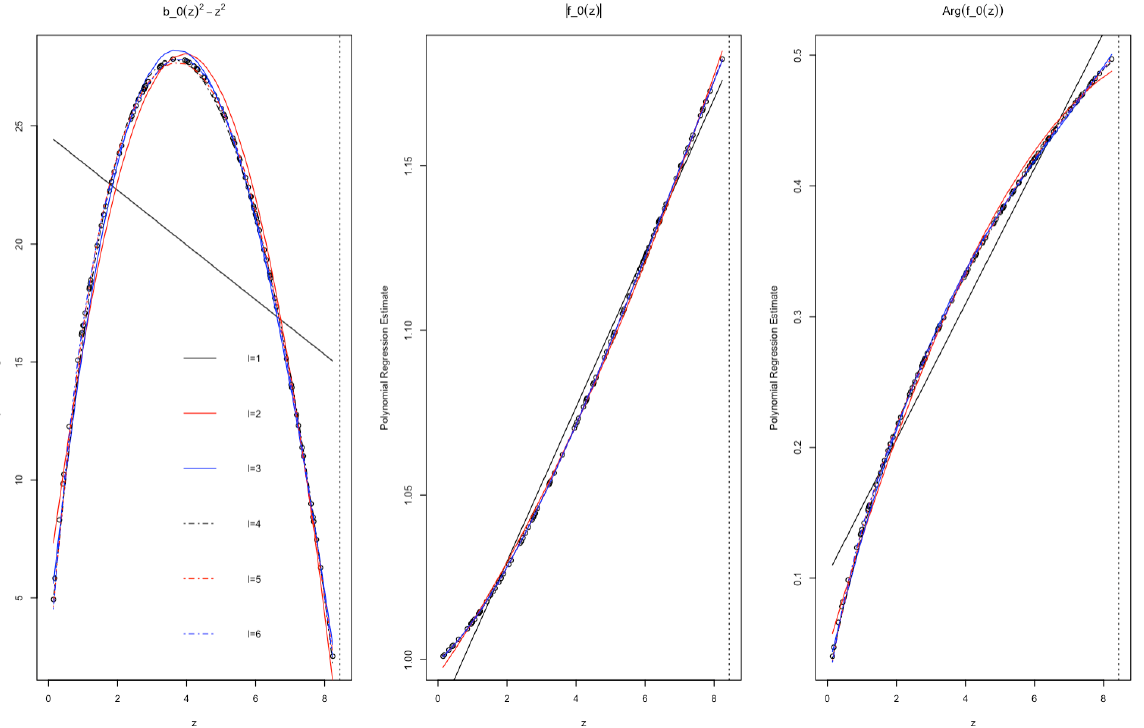
Figure 10. The estimates of critical collapse functions corresponding to a γ solution of a hyperbolic case based on a polynomial regression method of orders l = { 1, . . . ,6 } based on a training sample of size n =